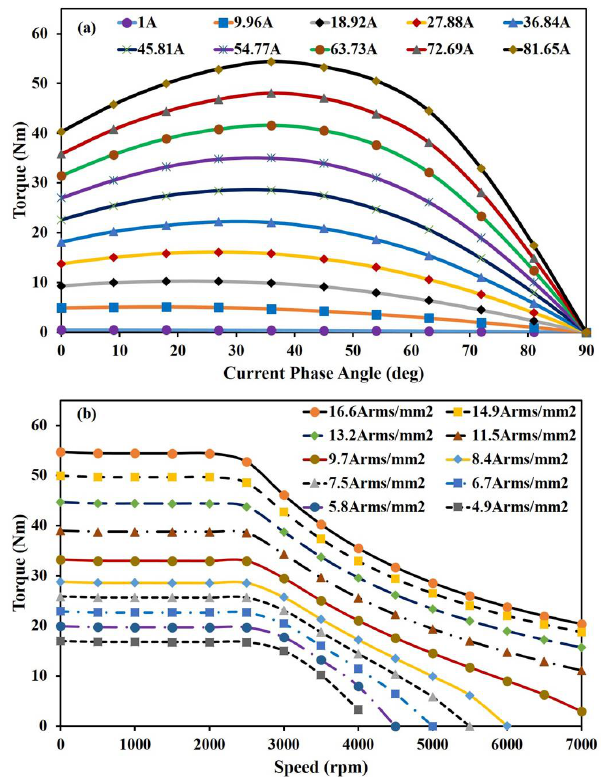
Figure 10. ( a ) Torque-current angle and ( b ) torque-speed curves of IPMSM.